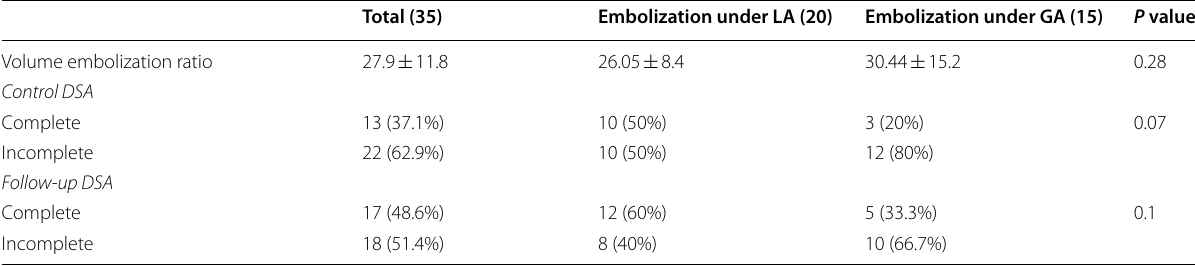
Table 2 Radiological outcome after aneurysm coiling